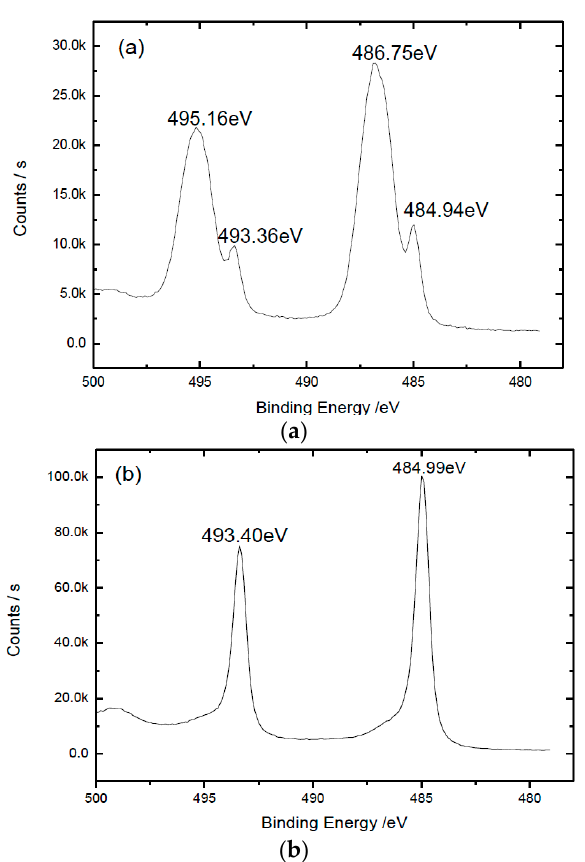
Figure 1. XPS spectrum of Sn 3d2/5 electrons on Sn-0.4Ti alloy ( a ) without sputtering; ( b ) with sputtering for 130 s.